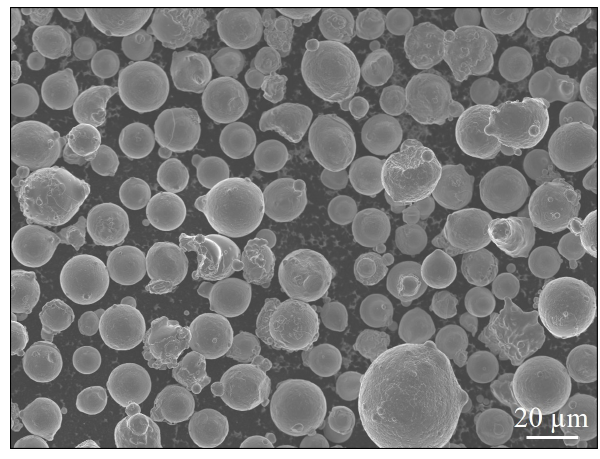
Figure 1. SEM image of the virgin powder.